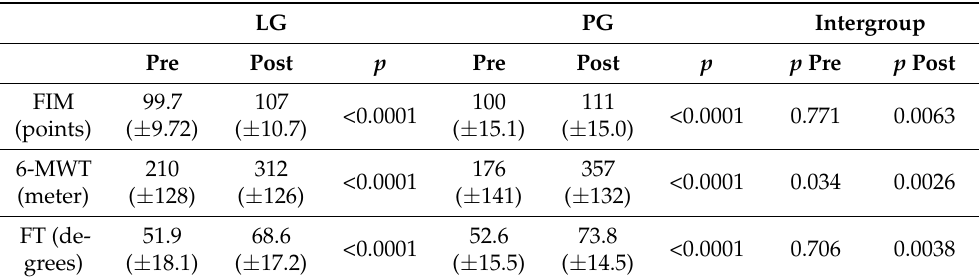
Table 6. Inter- and intragroup comparisons of FT, FIM and 6-MWT on admission and discharge to PR. LG PG Intergroup